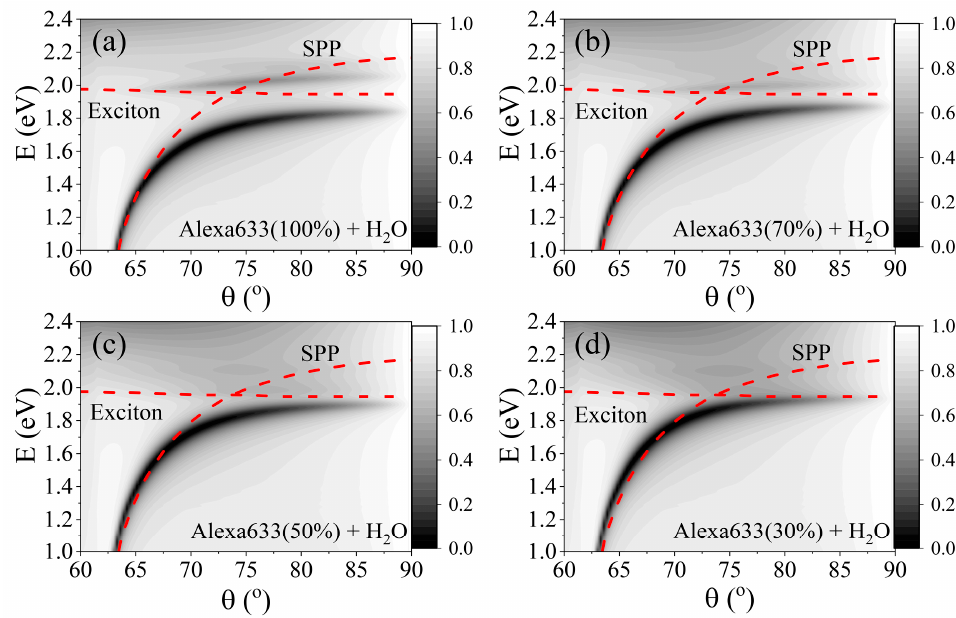
Figure 4. Dispersion maps of hybrid SPP–exciton modes for different Alexa633/H20 mixture ratios: ( a ) 100% Alexa Fluor TM 633, ( b ) 70%, ( c ) 50% and ( d ) 30%.